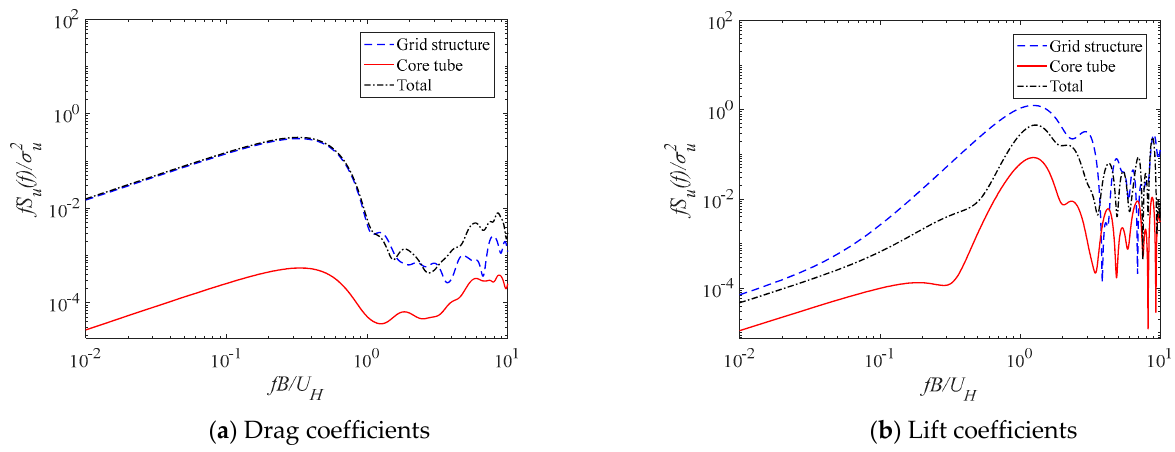
Figure 31. Lift and drag coefficients spectra of the grid structure and the core tube.